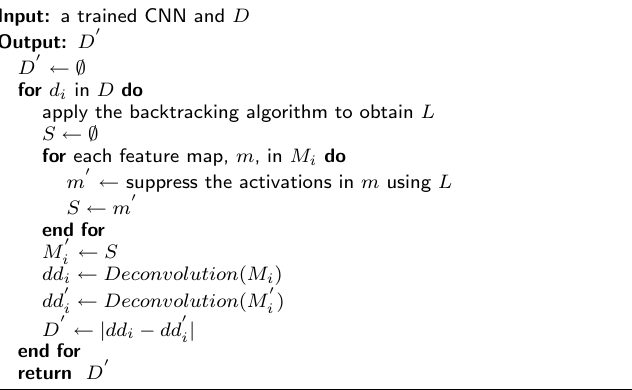
Algorithm 2 The Feature Tracking Process